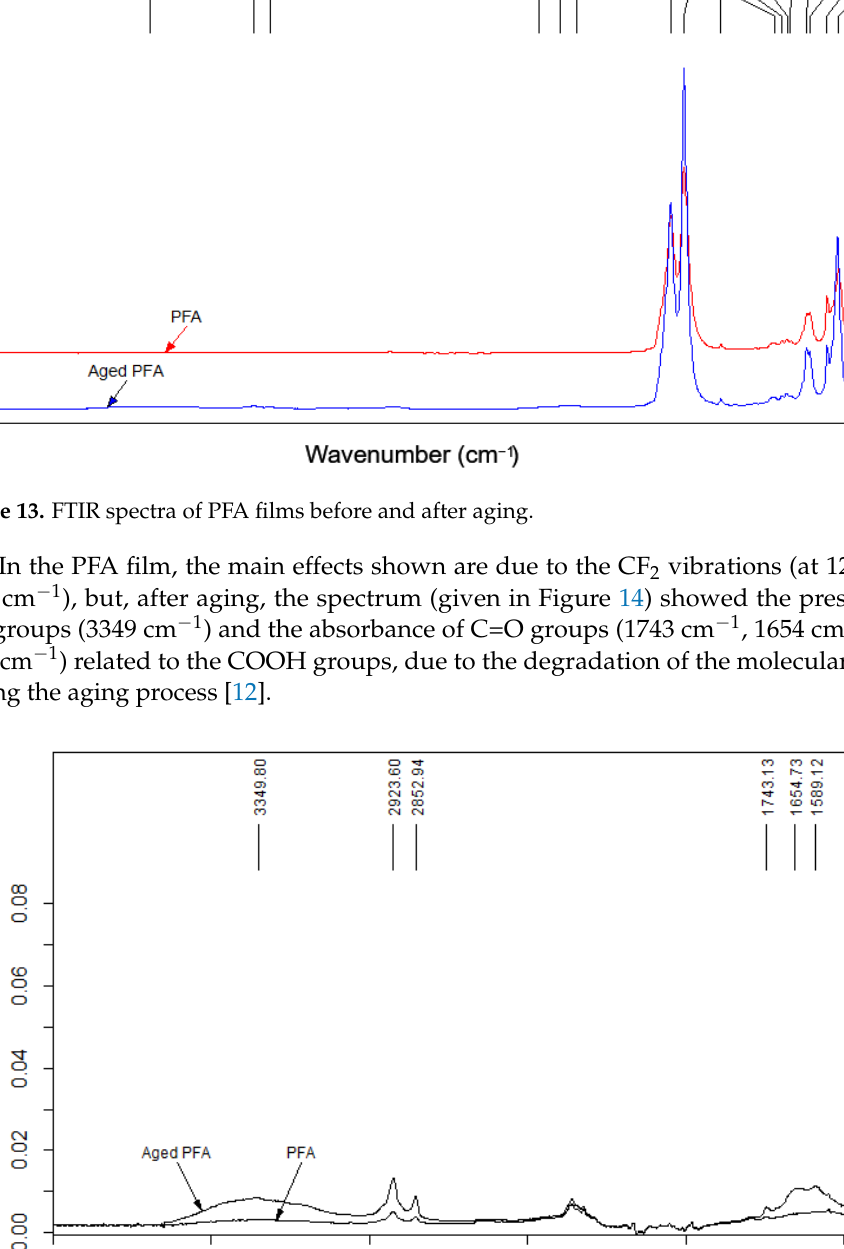
13 of 17 Figure 12. FTIR spectra of ETFE films before and after aging.